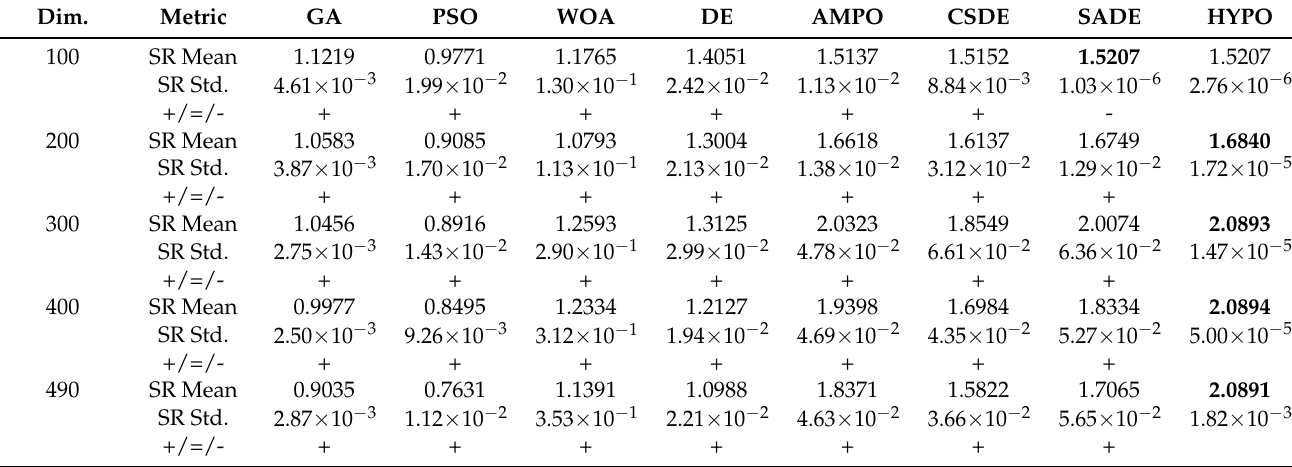
Table 6. Comparative Results on the SP500 Set.